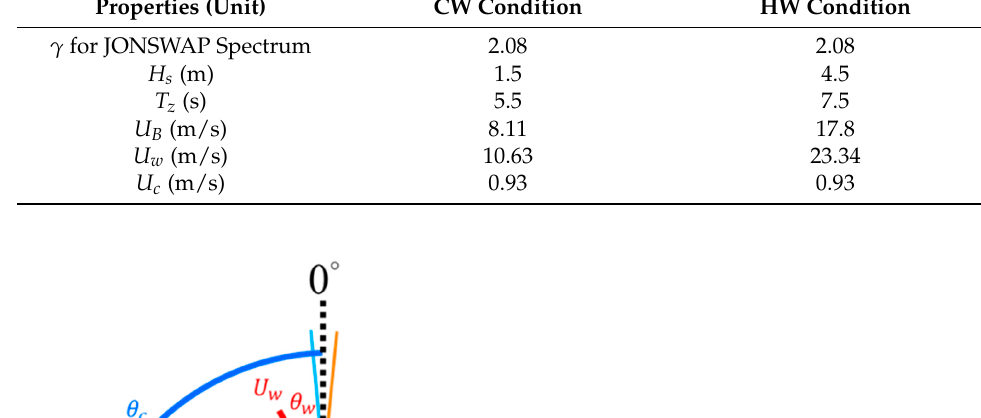
Figure 10. Definition of wind, wave, and current directions.